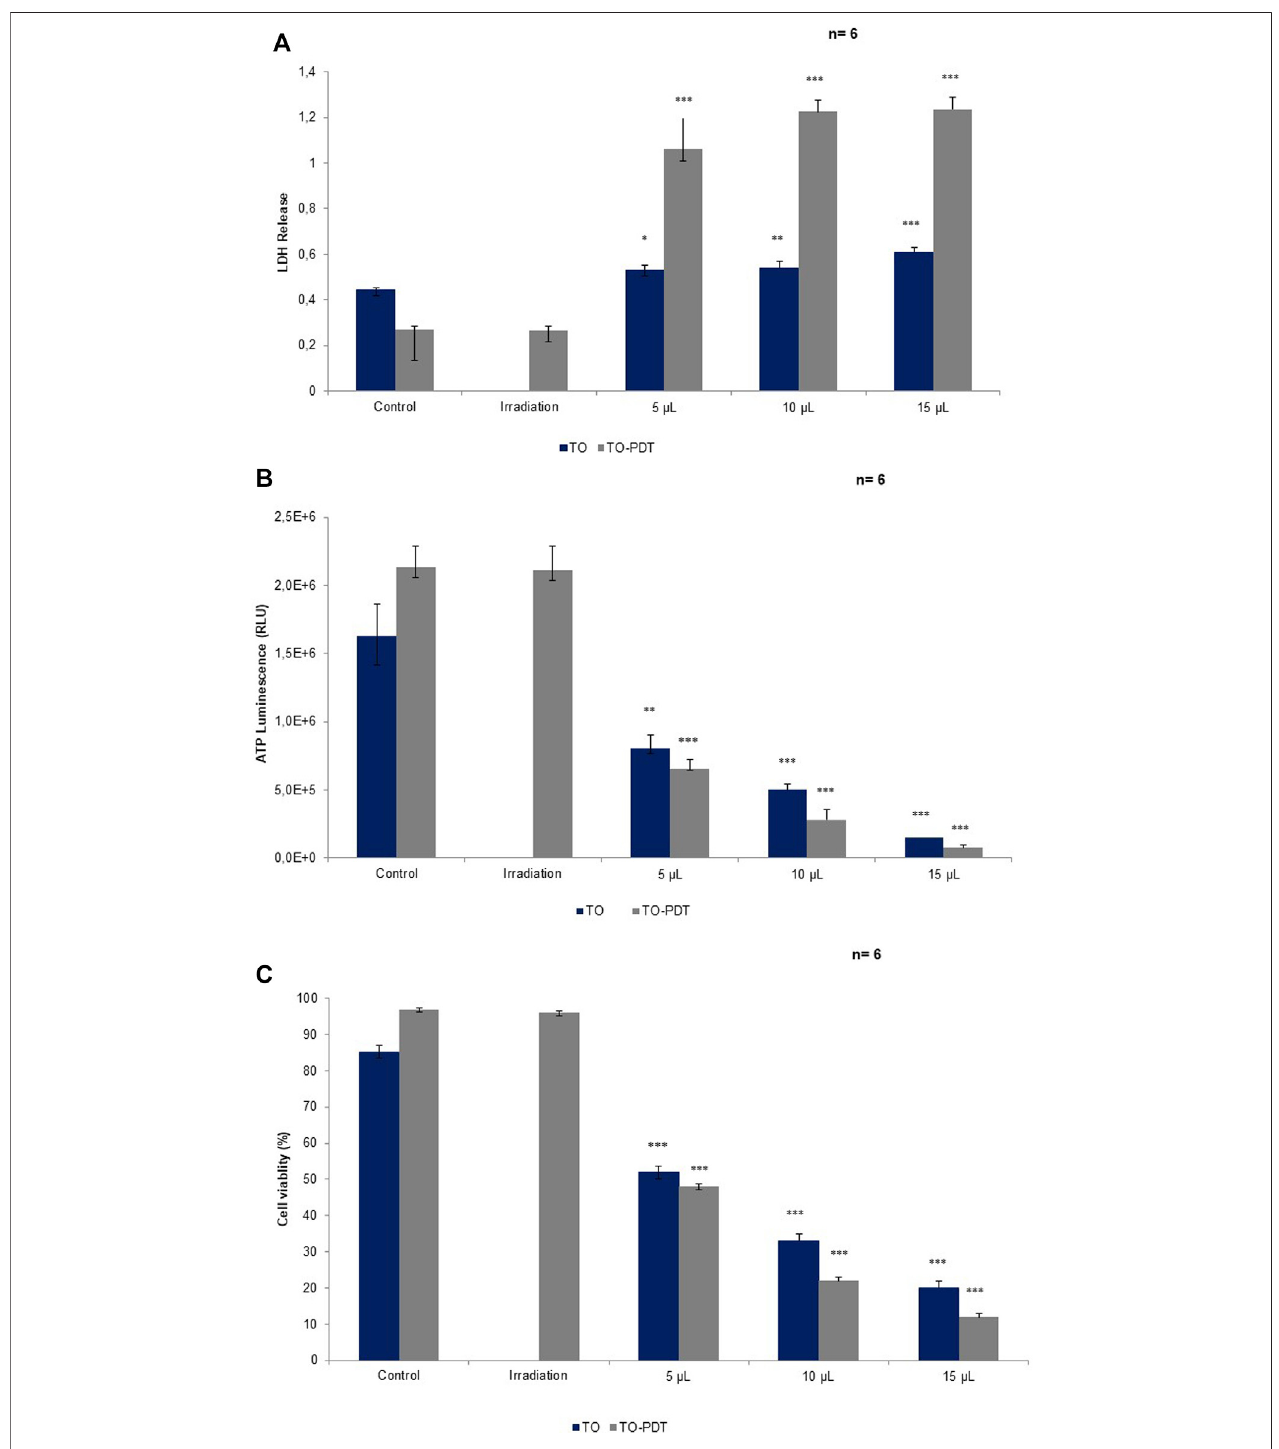
FIGURE 4 | A comparison of (A) LDH, (B) ATP, and (C) cell viability levels on A549 cells treated with Thuja occidentalis homeopathic mother tincture (TO) and TO mediated photodynamic therapy (TO-PDT) at the same doses of the tincture. At the same doses, TO when used as a photosensitizer in PDT, produced ampli fi ed antiproliferative and cytotoxic responses on A549 cells compared to cells treated with TO alone.